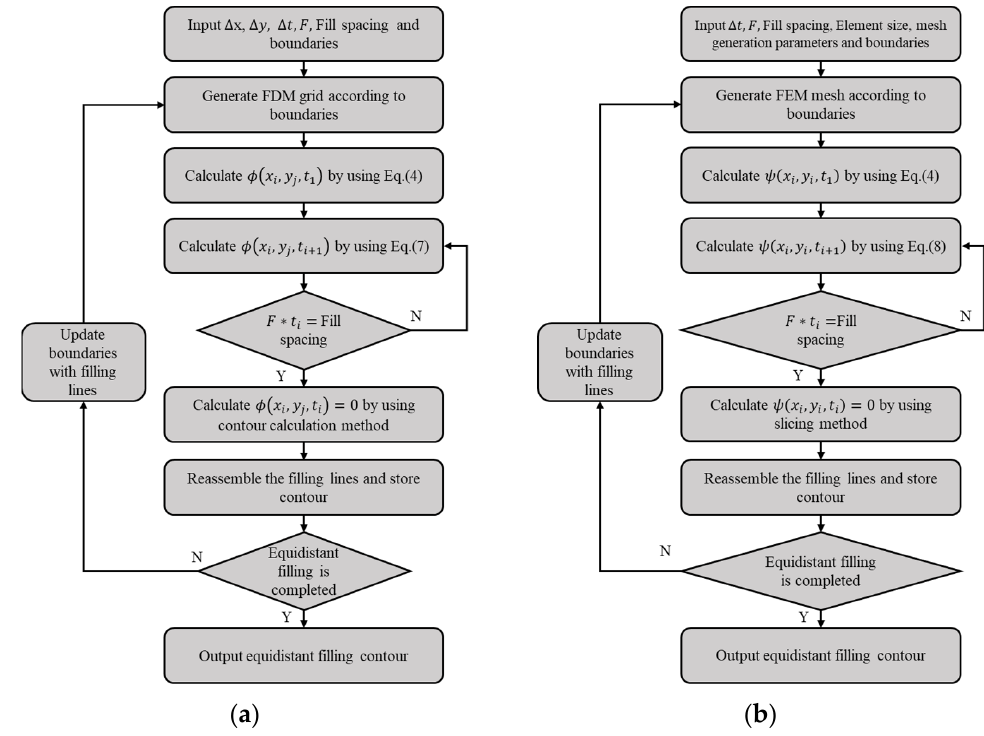
Figure 5. Flow chart of the new contour parallel path generation algorithm using different methods: ( a ) FDM; ( b ) FEM.